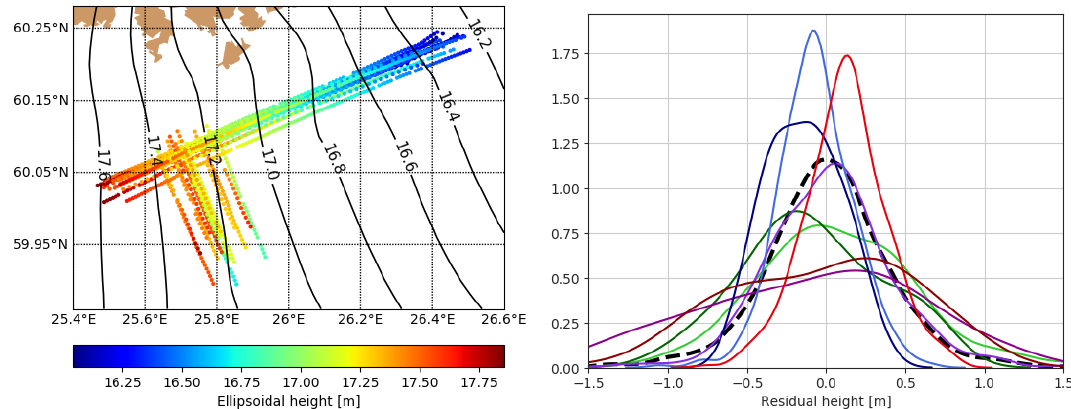
Figure 9. ( Left ) Results from the linear fits applied to SSH data located at their corresponding specular points. The contour lines of Finnish N2000 height system plus the mean value of in-situ sea level estimation are included (black lines and meter units). ( Right ) Estimated probability density function of ∆ SSH for each GNSS signal (same color code as in previous Figure 8) and for their combination (black dashed line).